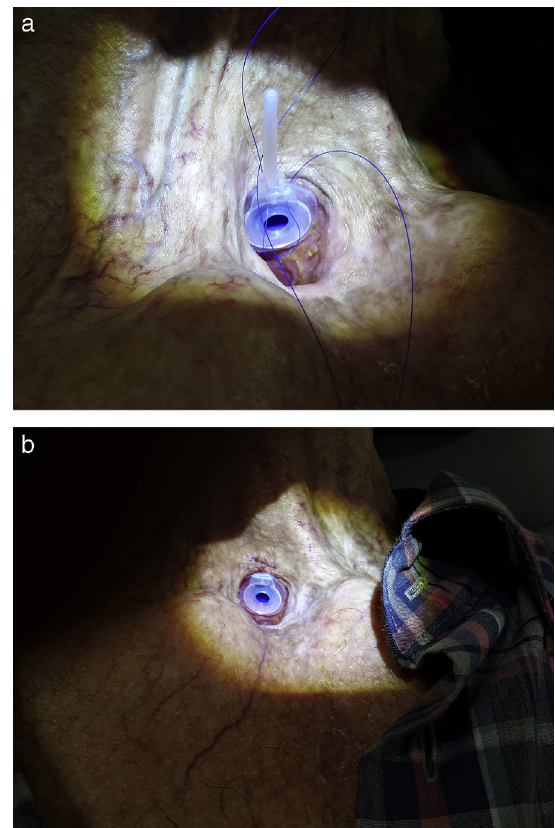
Figure 2 (a) The rings engaged with the tracheal and esophageal flanges of the voice prosthesis. (b) He upper side of the tracheal flange of the voice prosthesis was sutured to skin on the tracheostoma using 3.0 non-absorbable sutures.